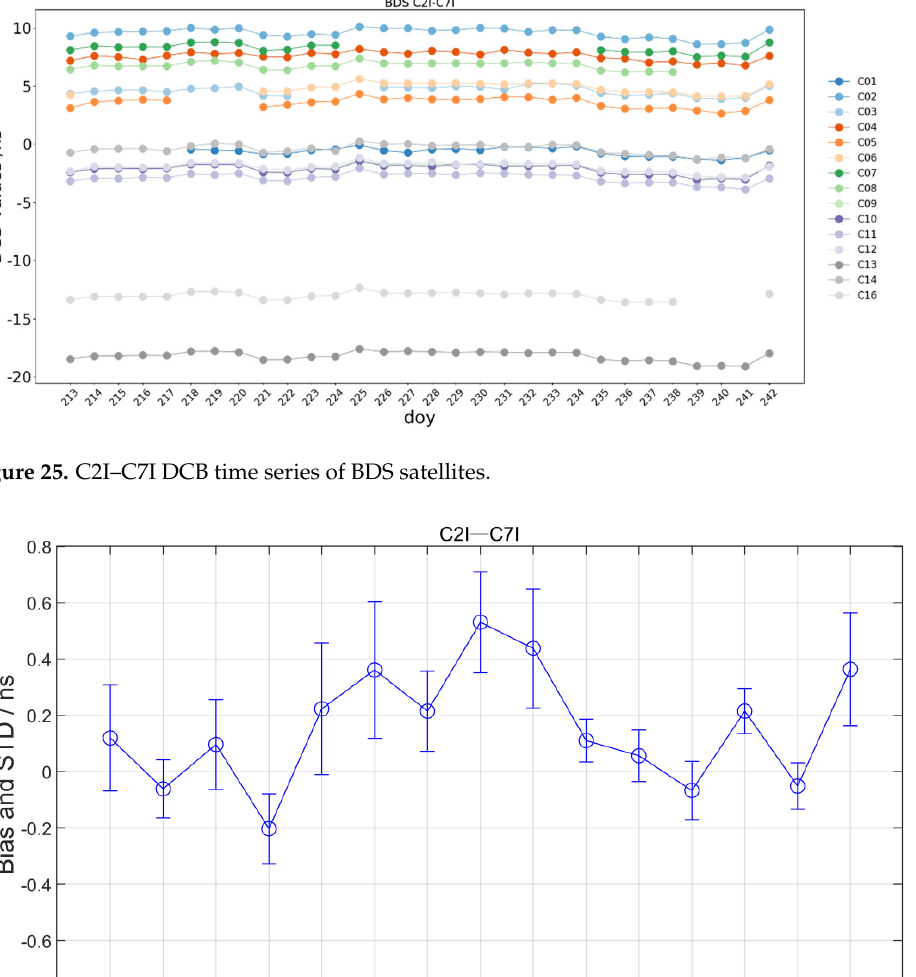
Figure 24. Comparison results between DCB and CAS products of Galileo satellite.